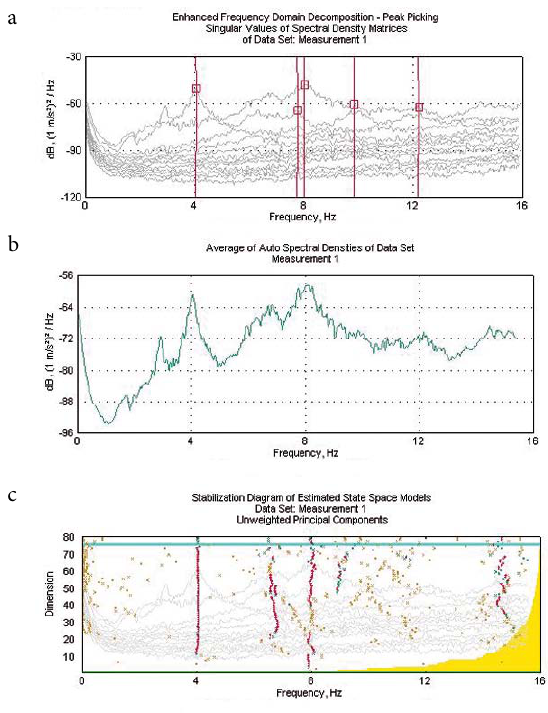
Fig. 8. Modal parameters attained using PP and SSI methods: a – singular values of spectral density matrices; b – average of auto spectral density; c – stabilization diagram of estimated state